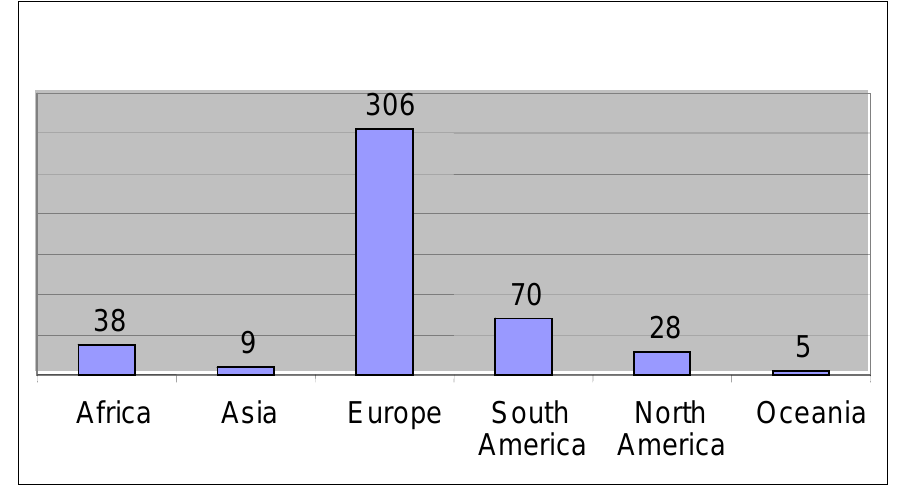
Chart 2: Number of Social Forum Organizations per